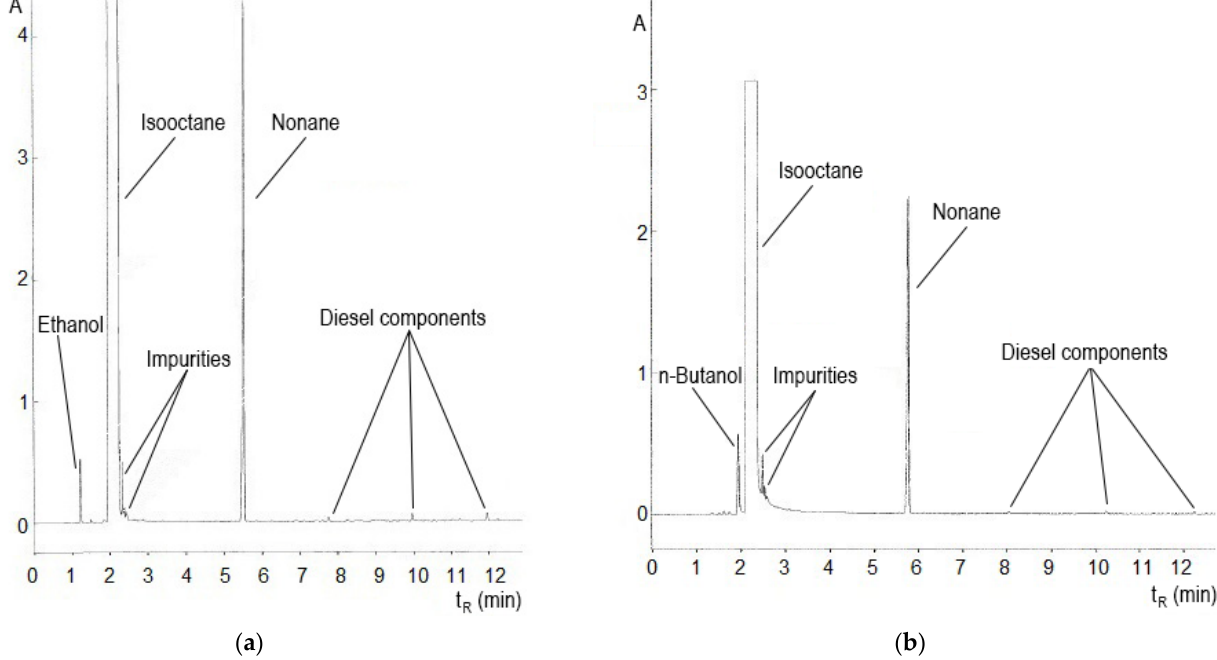
Figure 11. ( a ) Distillation curve of E10 mixture; ( b ) distillation curve of BUT10 mixture. Table 7. Measured concentrations of ethanol and n-butanol in diesel